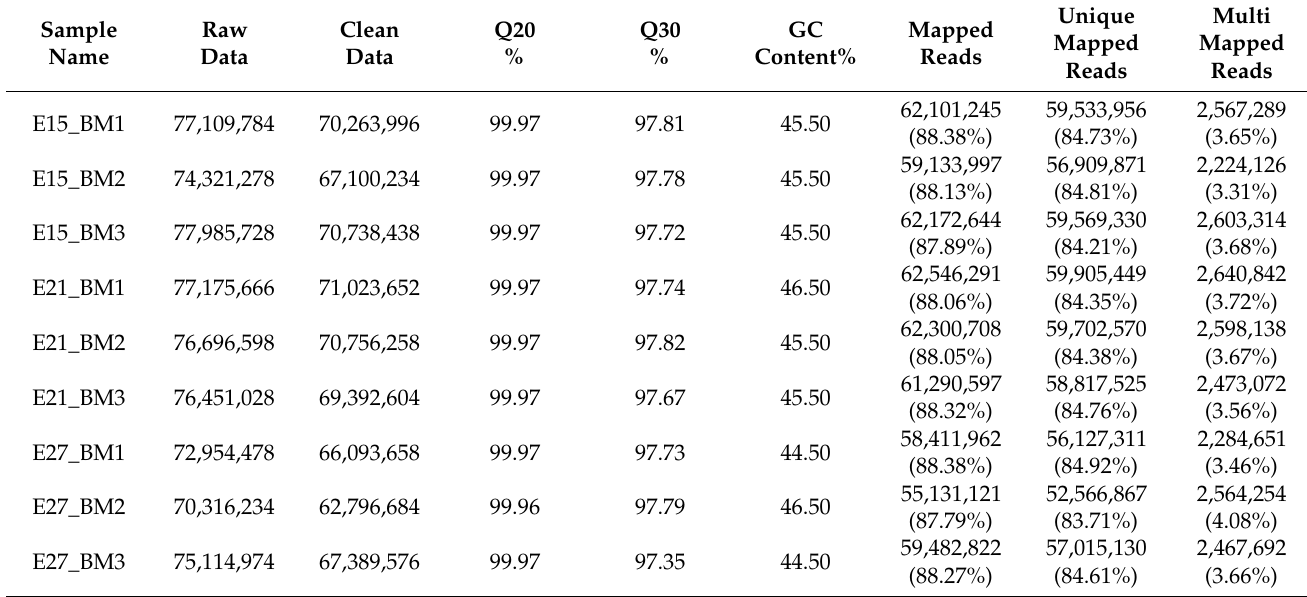
Table 1. RNA-Seq data from breast muscle of Pekin